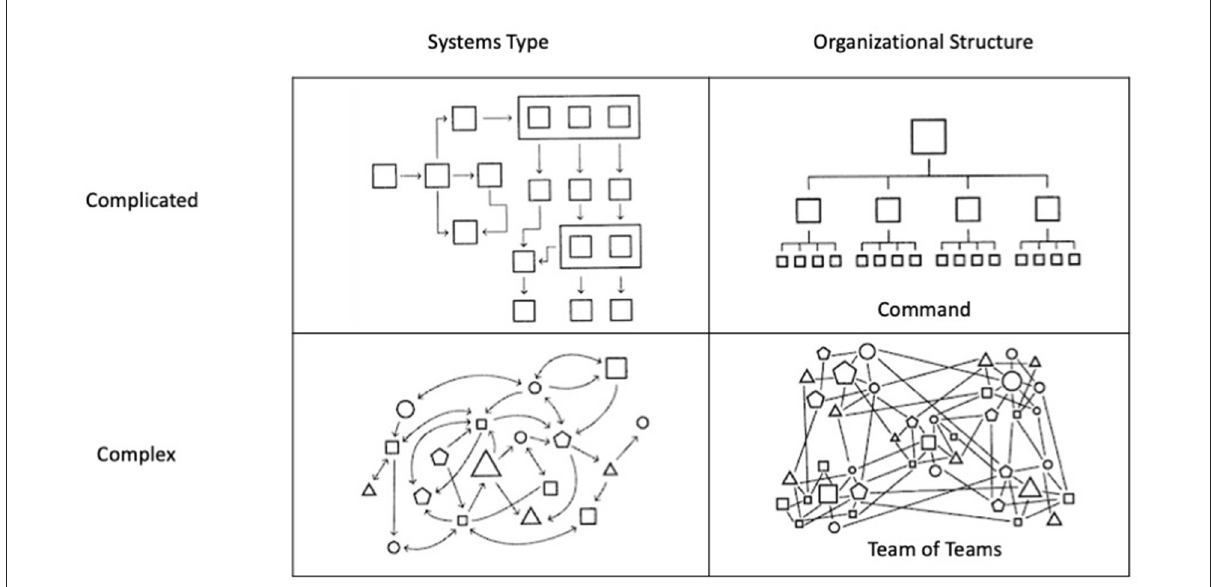
FIGURE3 Systems View: Linking complicated and complex systems to organizational structures. The type of problem to be solved has important implications for the organizational structure adopted to solve the problem. Complicated problems can be broken down into its subcomponents without regard for interactions among subcomponents. In contrast, solutions to complex problems have to account for interactions among subcomponents (Inspired by McChrystal et al.,